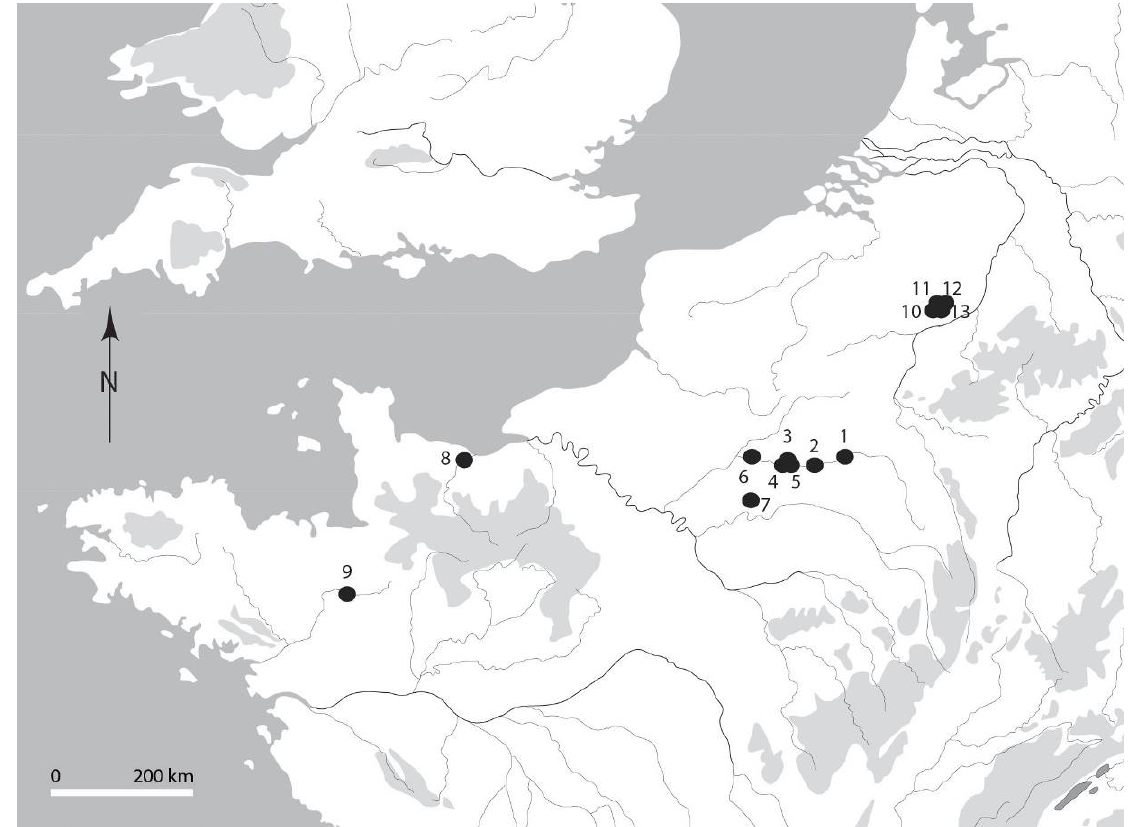
Figure 1. Map of the 13 sites where the study of the macrolithic tools was conducted: a. Berry-au-Bac - le Vieux Tordoir; 2. Cuiry-les-Chaudardes - les Fontinettes; 3. Bucy-le-Long - la Fosselle; 4. Bucy-le-Long - le Fond du Petit Marais; 5. Bucy-le-Long - la Fosse Tounise; 6. Trosly-Breuil - les Obeaux; 7. Ocquerre - la Rocluche; 8. Colombelles - Le Lazzarro; 9. Betton – Pluvignon; 10. Remicourt - En Bia Flo II; 11. Fexhe - Le Haut Clocher; 12. Oleye - Al Zèpe; 13.